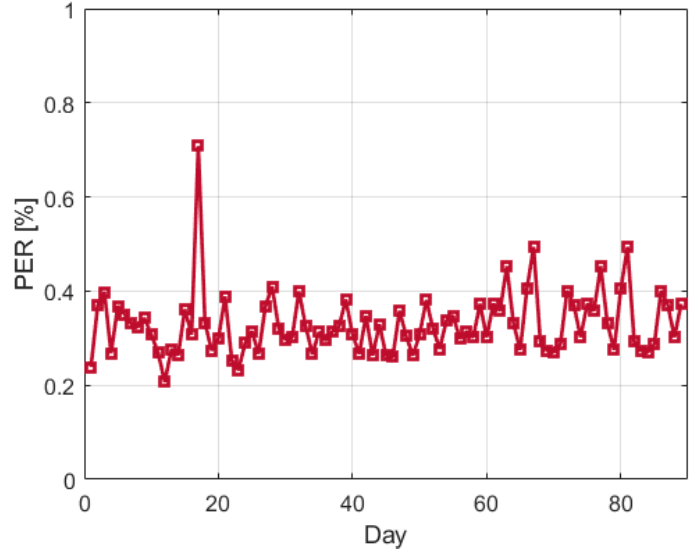
Figure 8. Daily PER for the period under analysis.